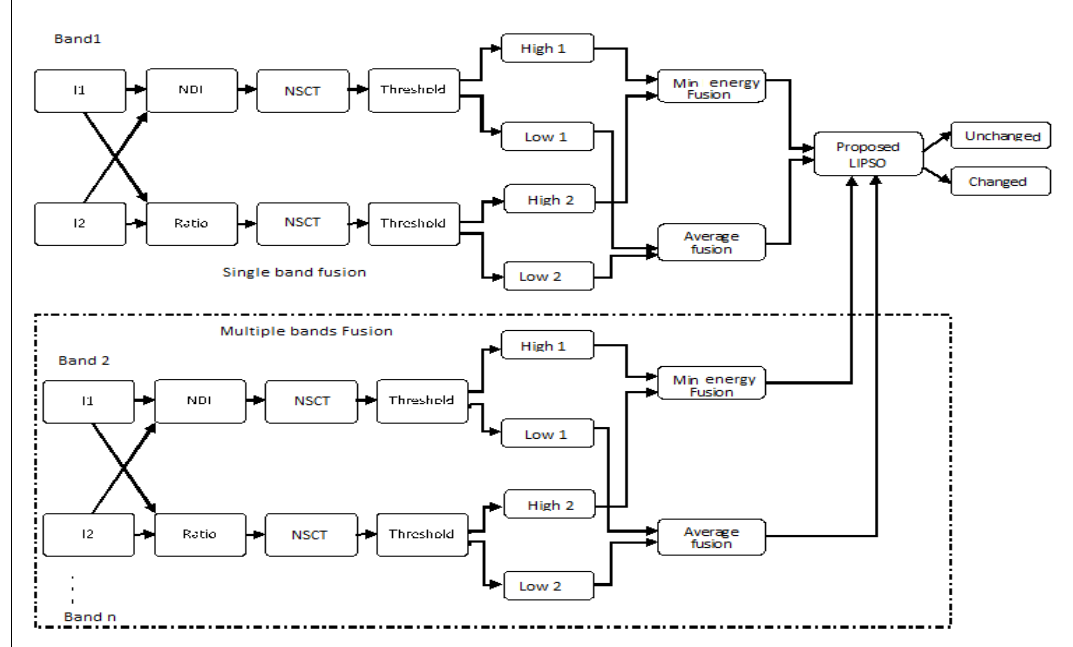
Figure 1. Block diagram of the